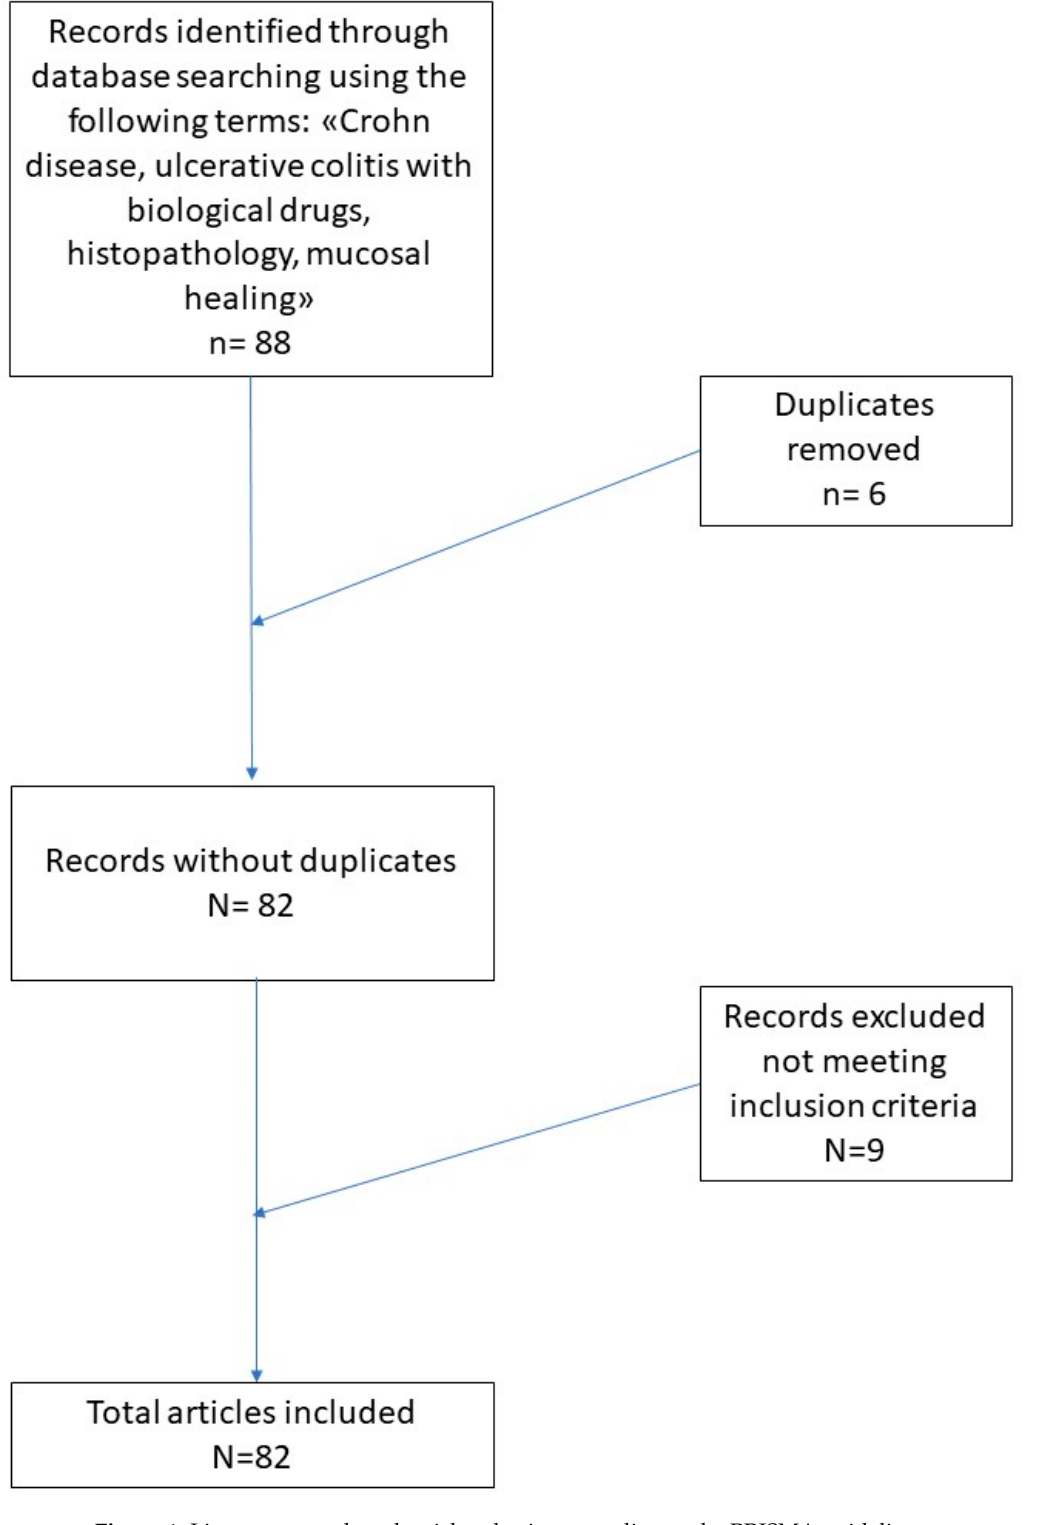
Figure 1. Literature search and article selection according to the PRISMA guidelines.